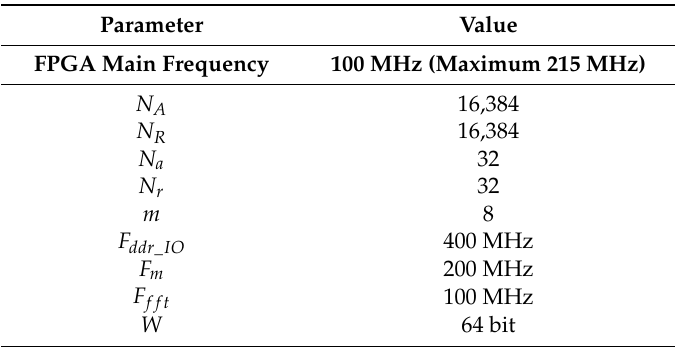
Table 9. Basic parameters of the system implementation.